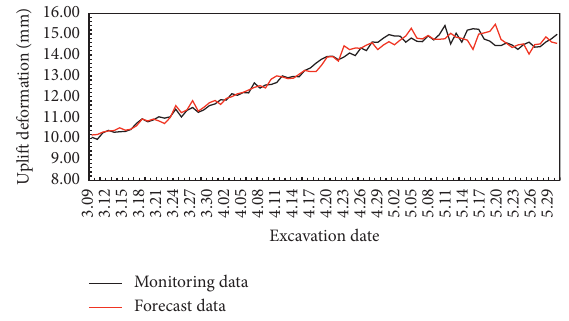
Figure 9: Predicted and measured uplift deformation of tunnel section DM12.